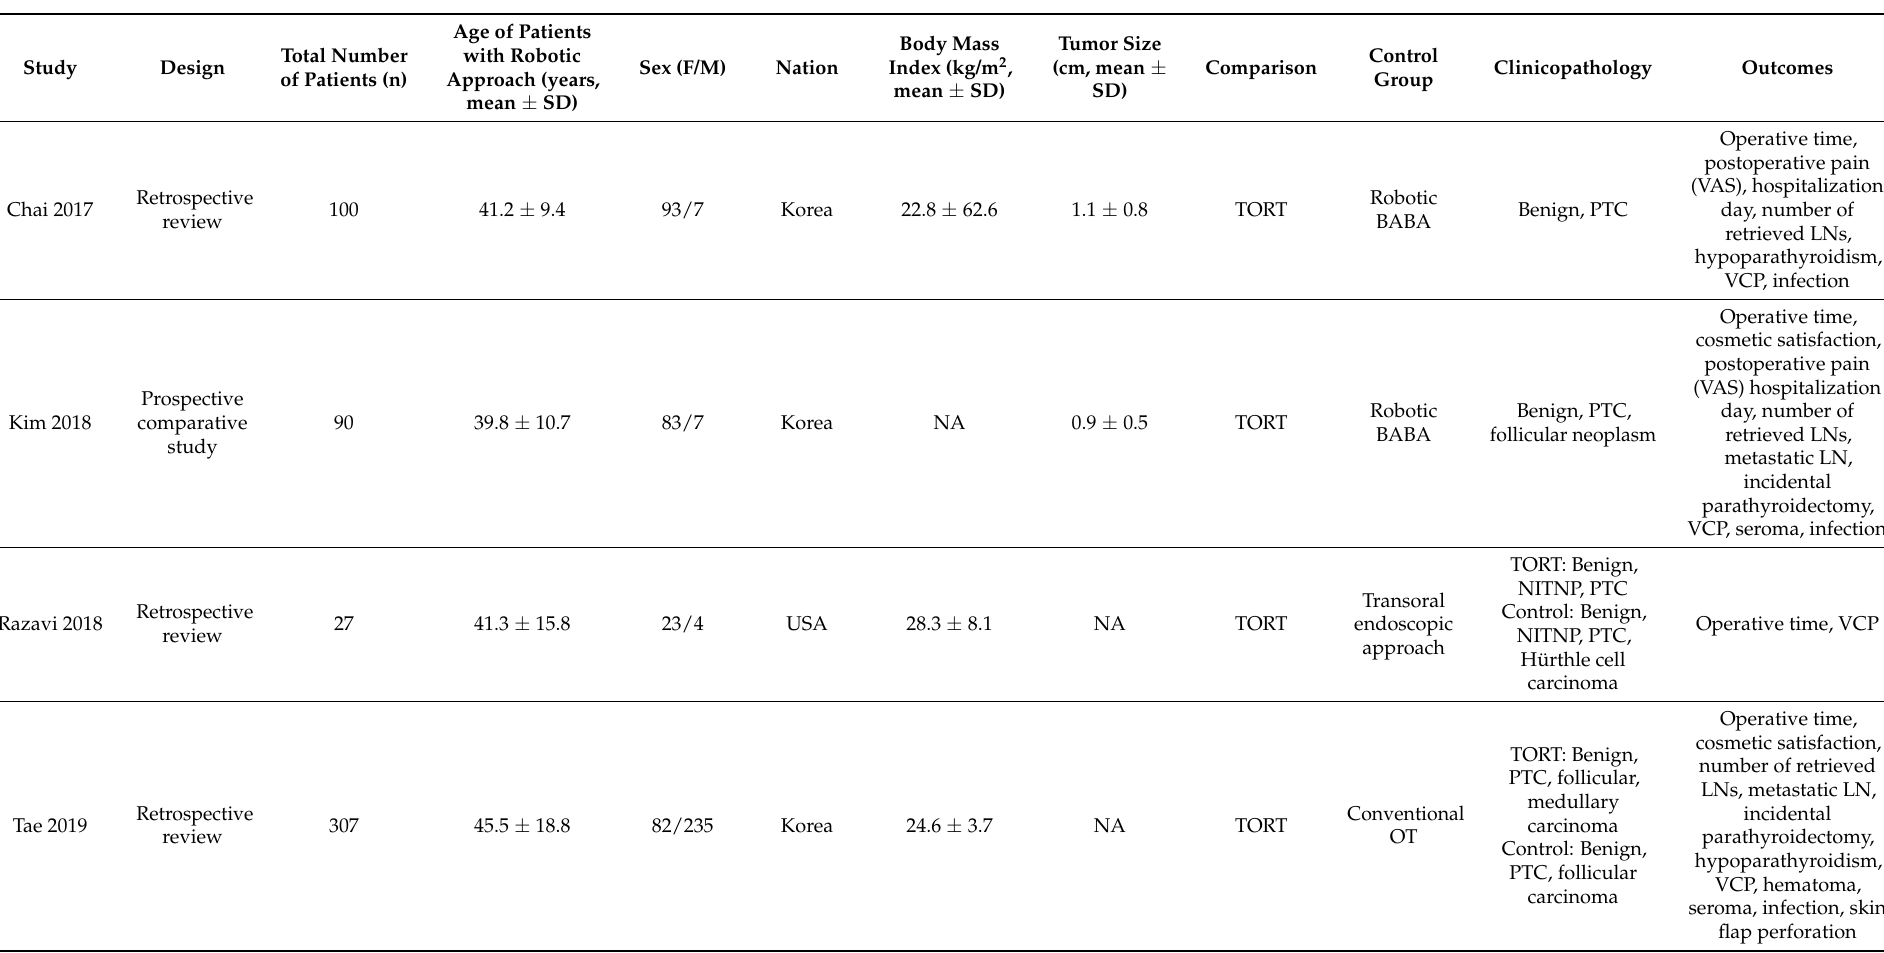
Table 1. The characteristics of included